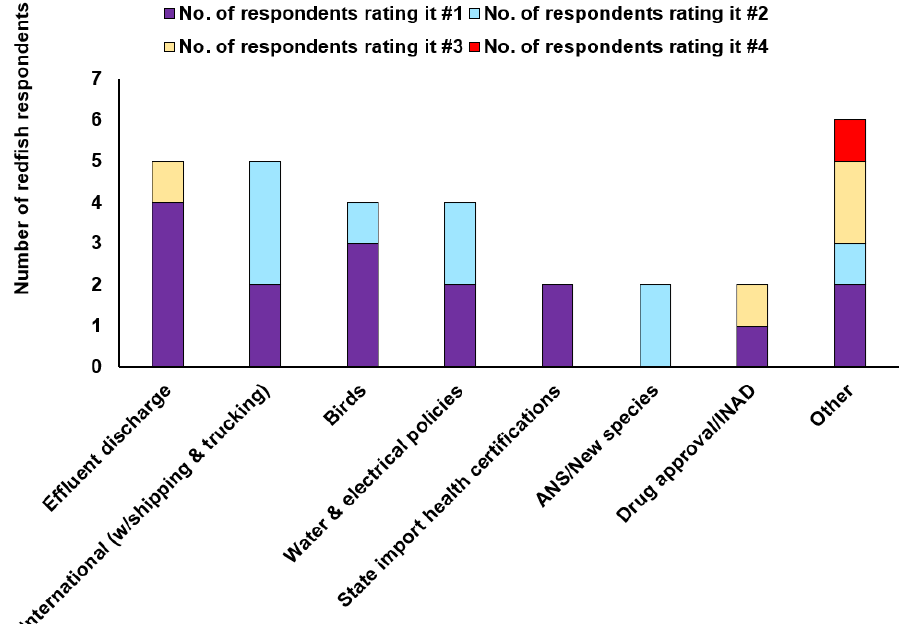
Figure 4. Producer responses to the following question: “Of all the regulations you deal with, which have created the greatest problems for your business, with #1 being the most problematic.” ( n = 24 respondents). “Other” includes: low-cost imports as barrier to entry, disease control (lack of approved antibiotics), FDA/processing regulations, OSHA, banking regulations, the cumulative effect of the total suite of regulations.